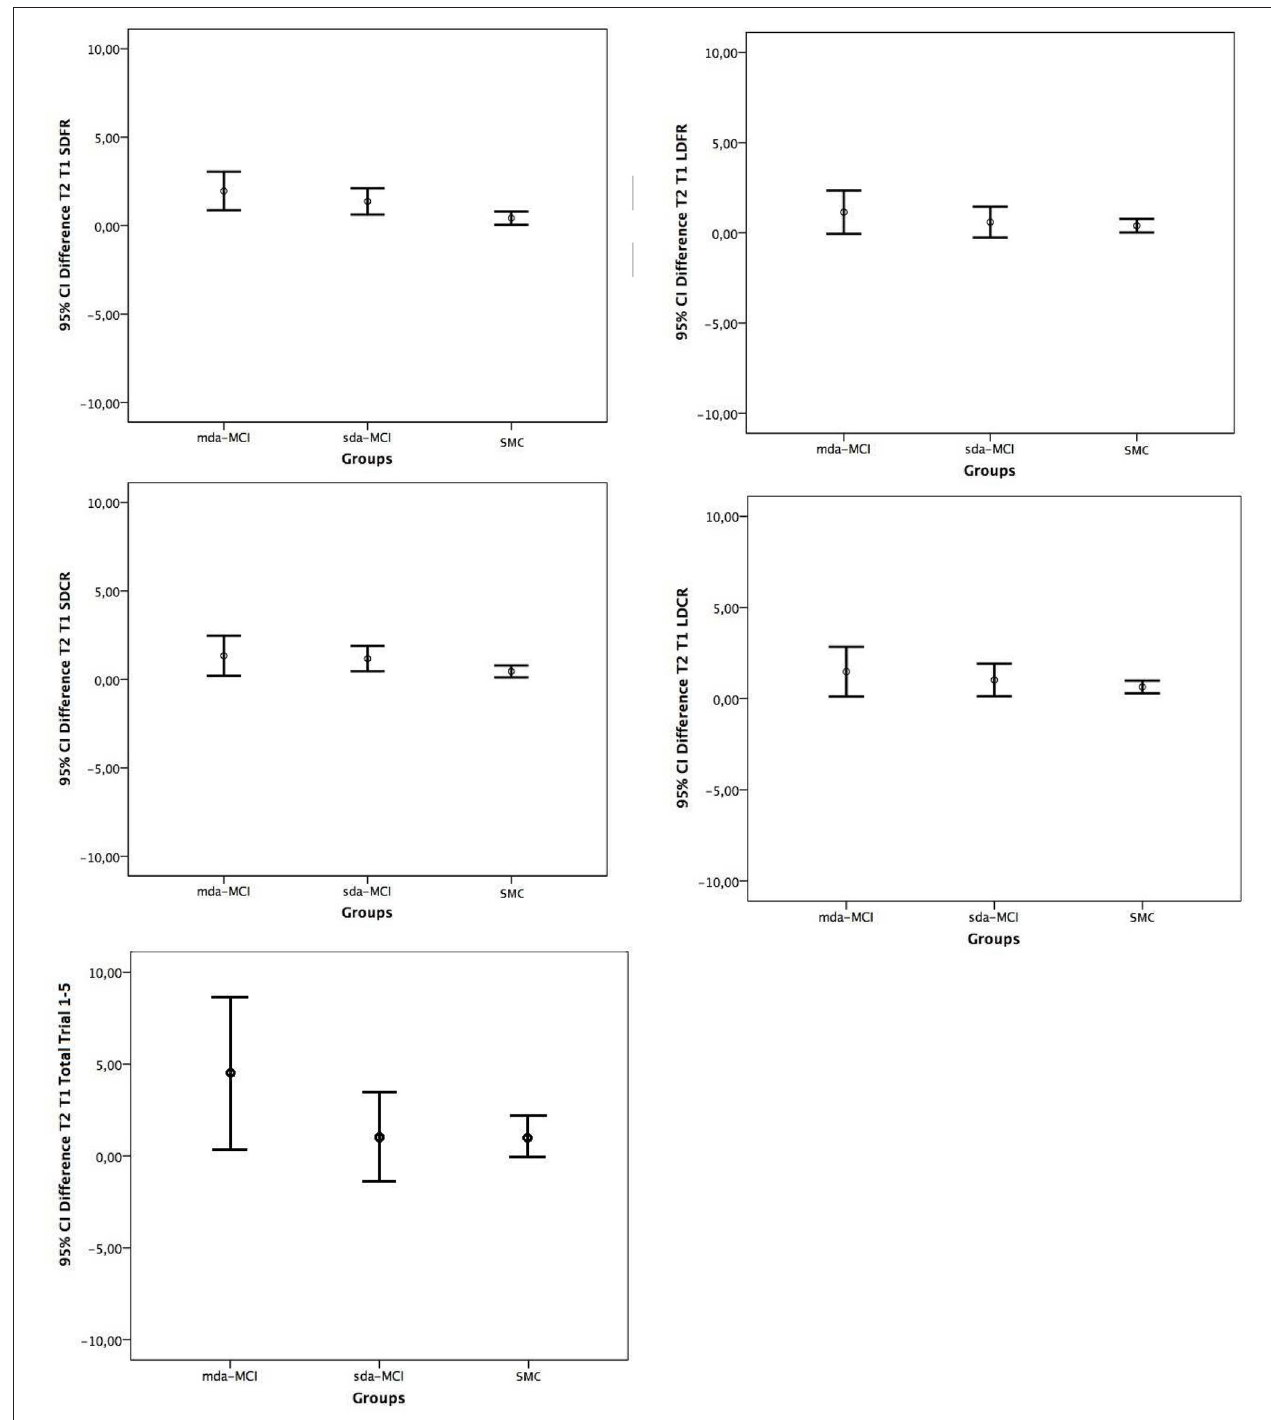
FIGURE 1 | Confidence intervals (95%) for Means Difference Time 2 and Time 1 in the California Verbal Learning Test primary measures, Short Delay Free Recall (SDFR), Short Delay Cued Recall (SDCR), Long Delay Free Recall (LDFR), and Long Delay Cued Recall (LDCR) and Total Trial 1–5, for the three groups: multiple domain amnestic mild cognitive impairment (mda-MCI), single domain amnestic mild cognitive impairment (sda-MCI), and controls with subjective memory complaints (SMC).